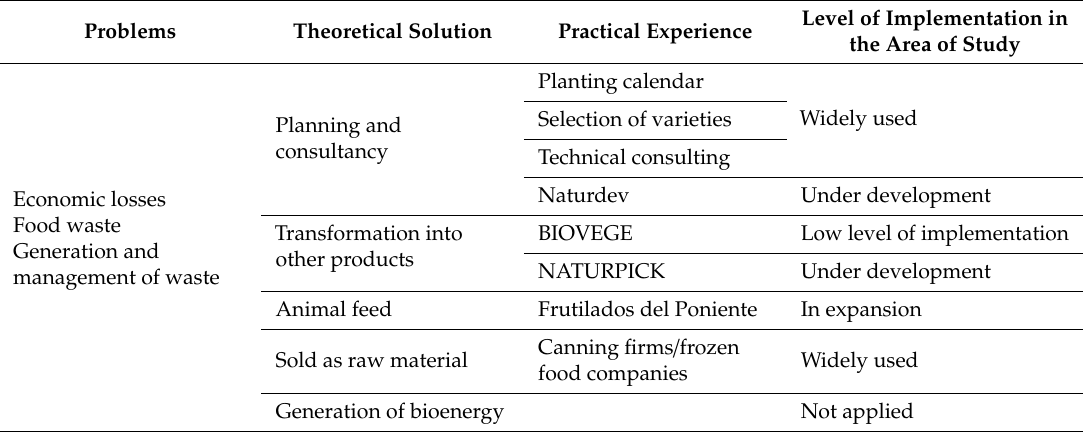
Table 7. Main solutions based on the CE for non-sellable products and